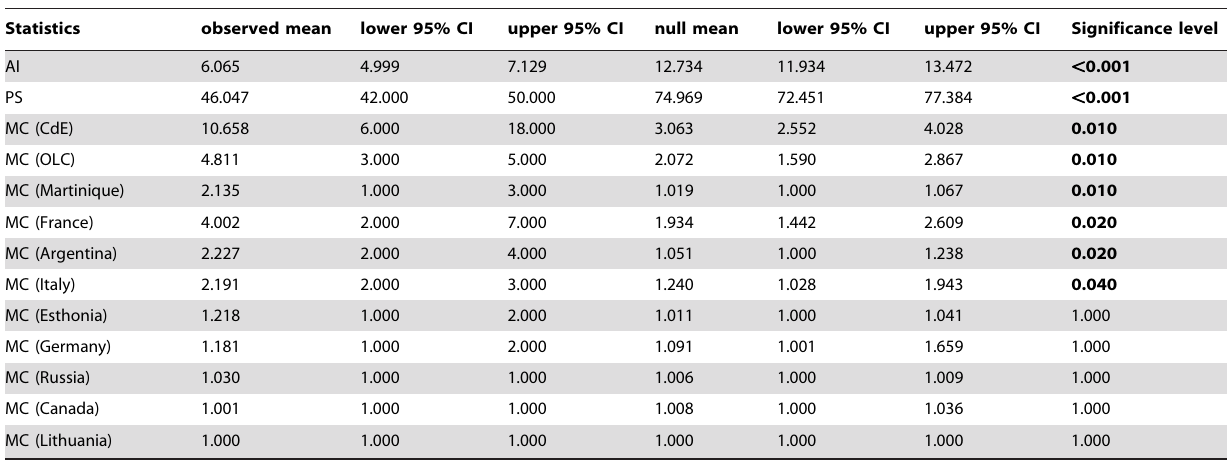
Table 3. Summary of association index for phylogeographic analysis.